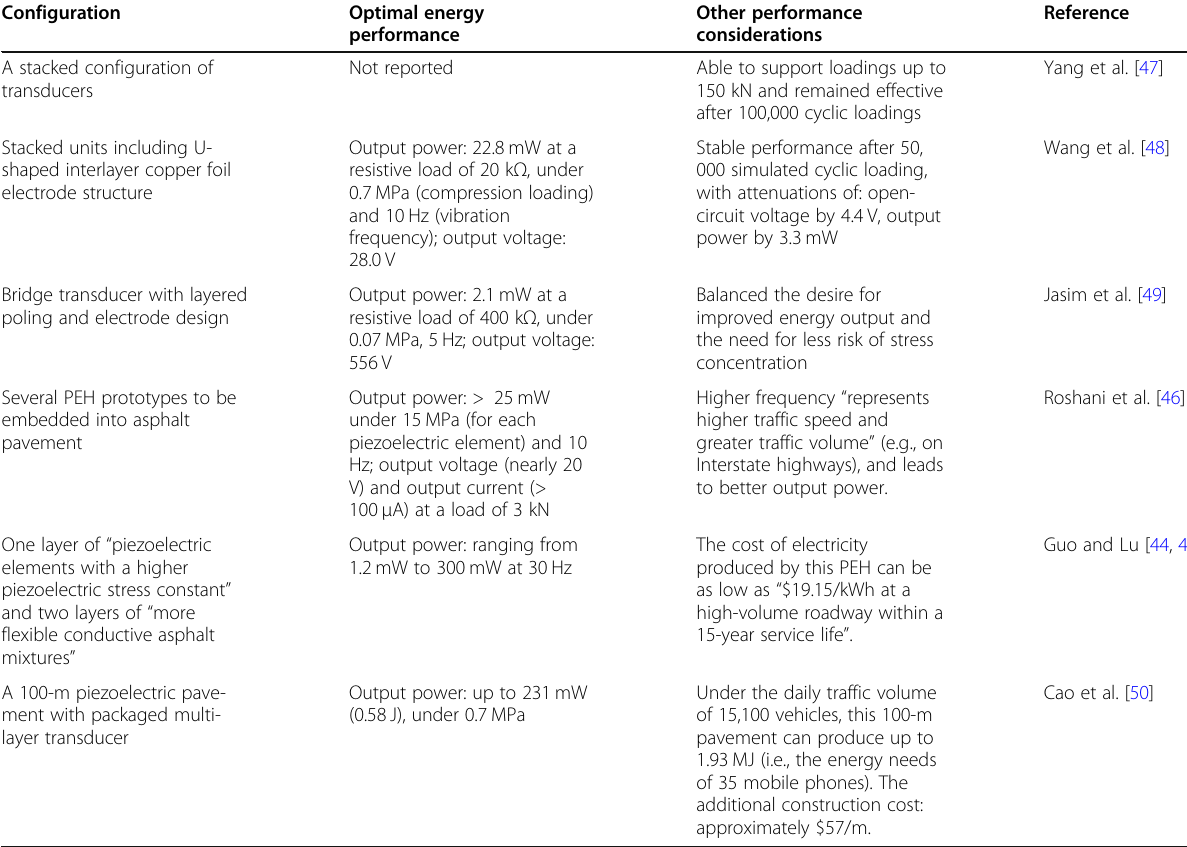
Table 1 Recent advances in PEH technology for